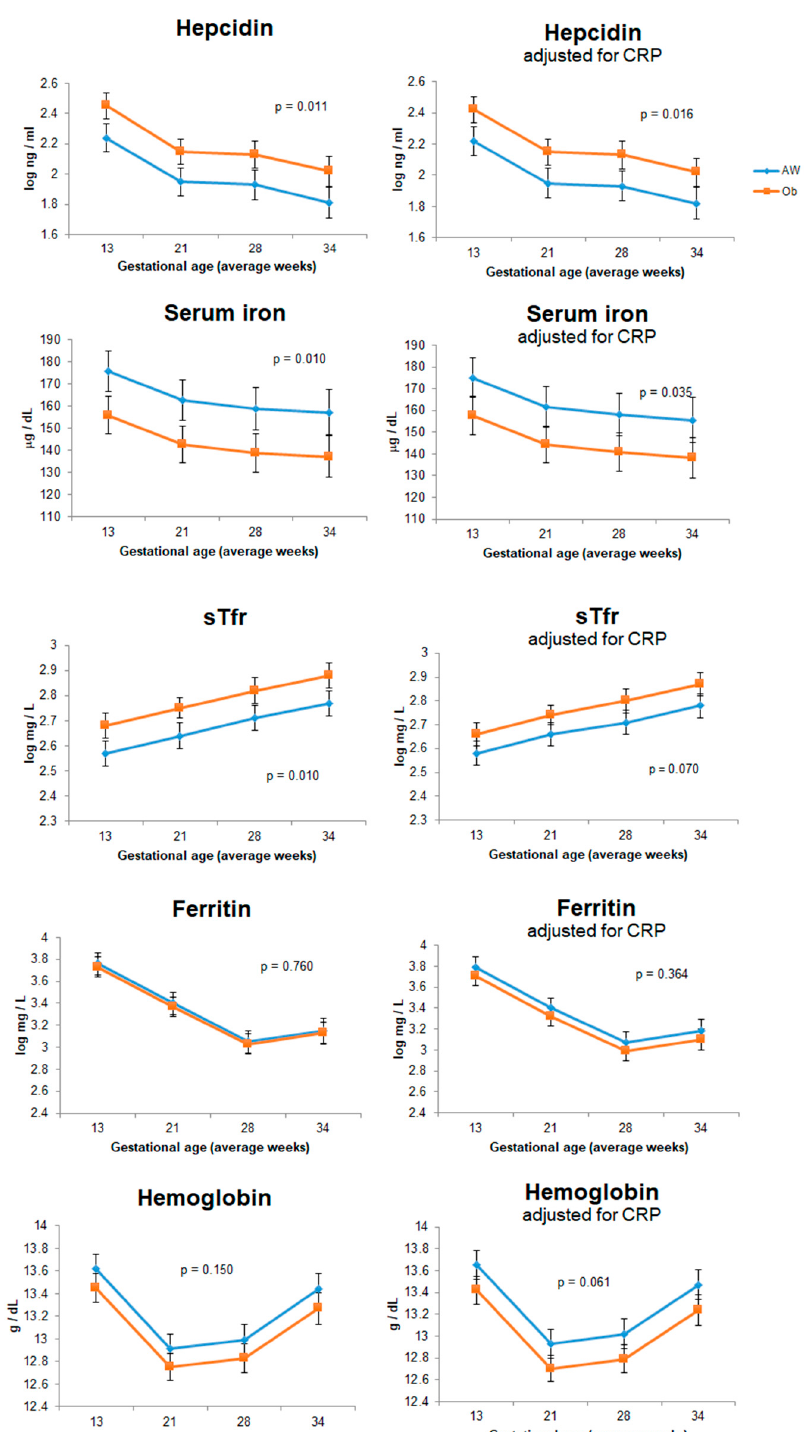
Figure 2. Differences in iron biomarkers between pregnant women with adequate weight (AW) ( ) and Ob ( ) . Graphs to the left show the results of generalized linear model (GLM) adjusted for study group (Ob and AW), gestational week, total iron intake, underlying health conditions, and pregnancy complications. Graphs to the right show the results of the same models adjusted for inflammation (adding C-reactive protein [CRP] as a covariable). In all models, hepcidin was considered as a covariable, except for the hepcidin model where sTfr was used. p -Values show the statistical difference between AW and Ob groups during pregnancy.